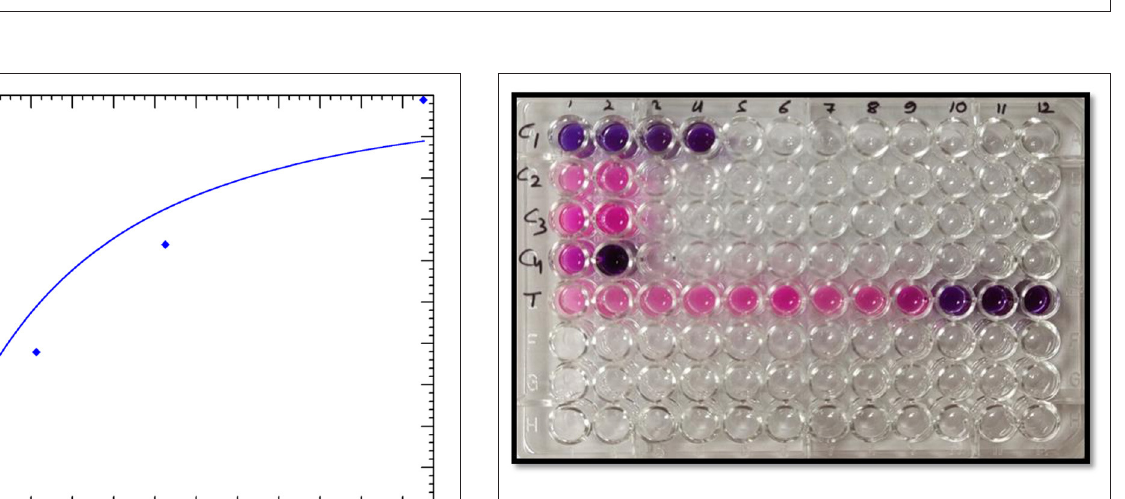
color change occurred, was 256 µ g ml − 1 corresponding to the treatment T9. In positive control (C4) comprising Nativo, the color change was observed at 1,024 µ g ml − 1 .